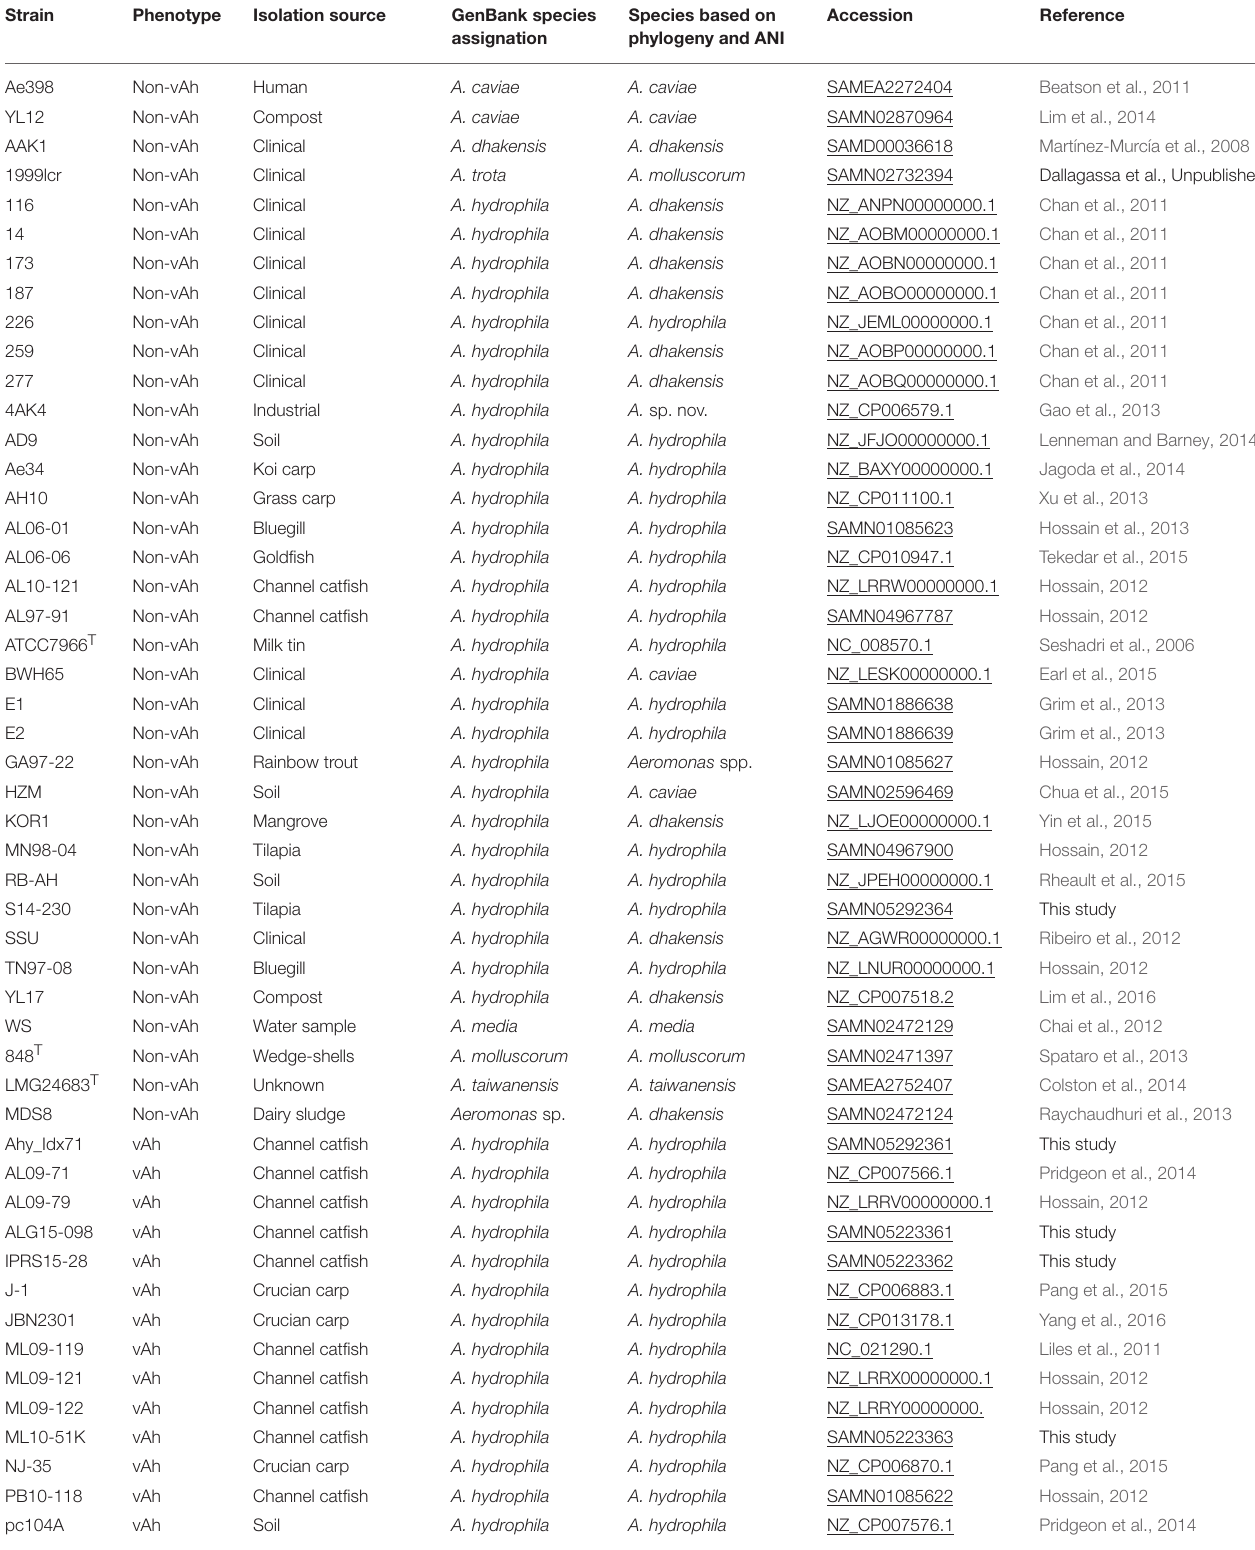
TABLE 1 | Bacterial genomes used in comparative genomic